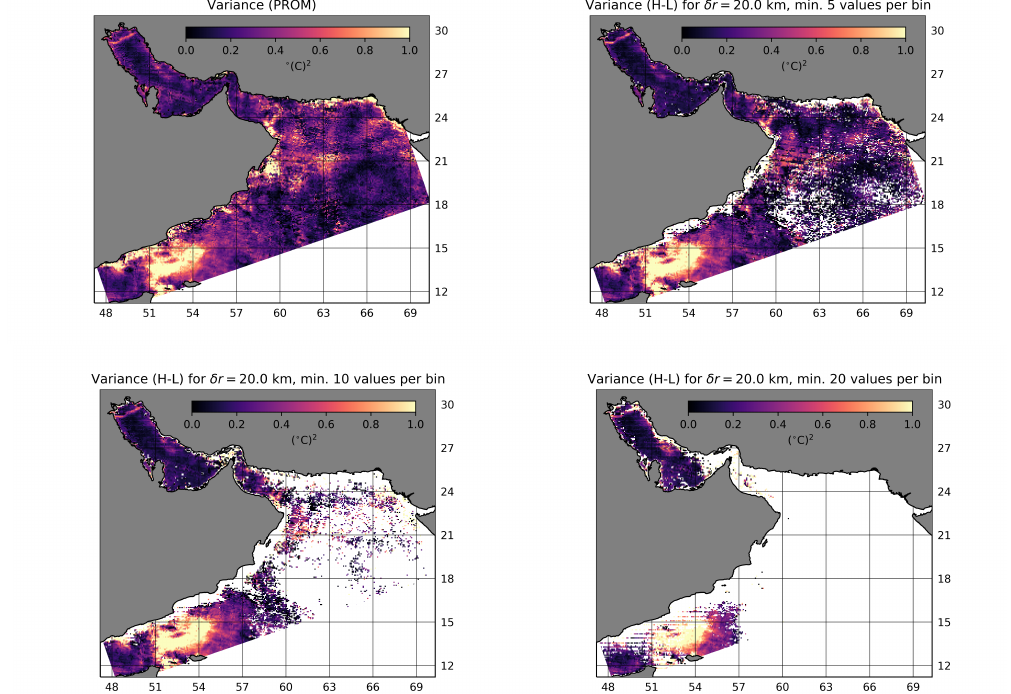
Figure 9. Background model error variances ( a 0 + a 1 ) computed using both methods. For H-L we have included results for bin sizes δ r = 20 m and different minimum number of days to consider a bin valid for computing covariances ( K = 5,10,20). H-L method is very sensitive to K, and only produces results in most of the domain nodes for K =